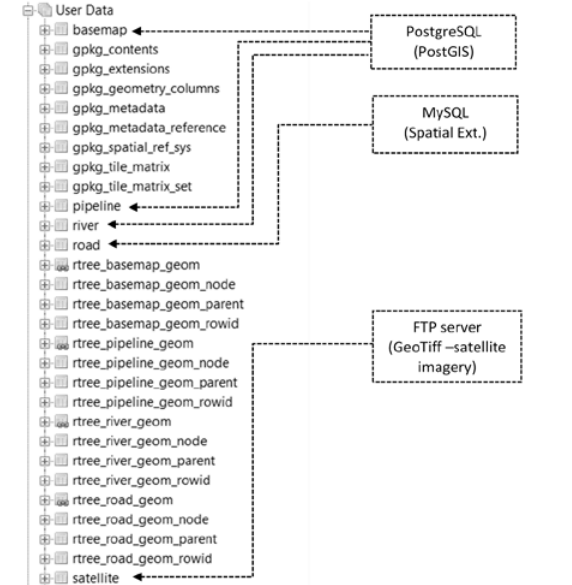
Figure 6. The data organization structure in GeoPackage for data integration of vector and raster